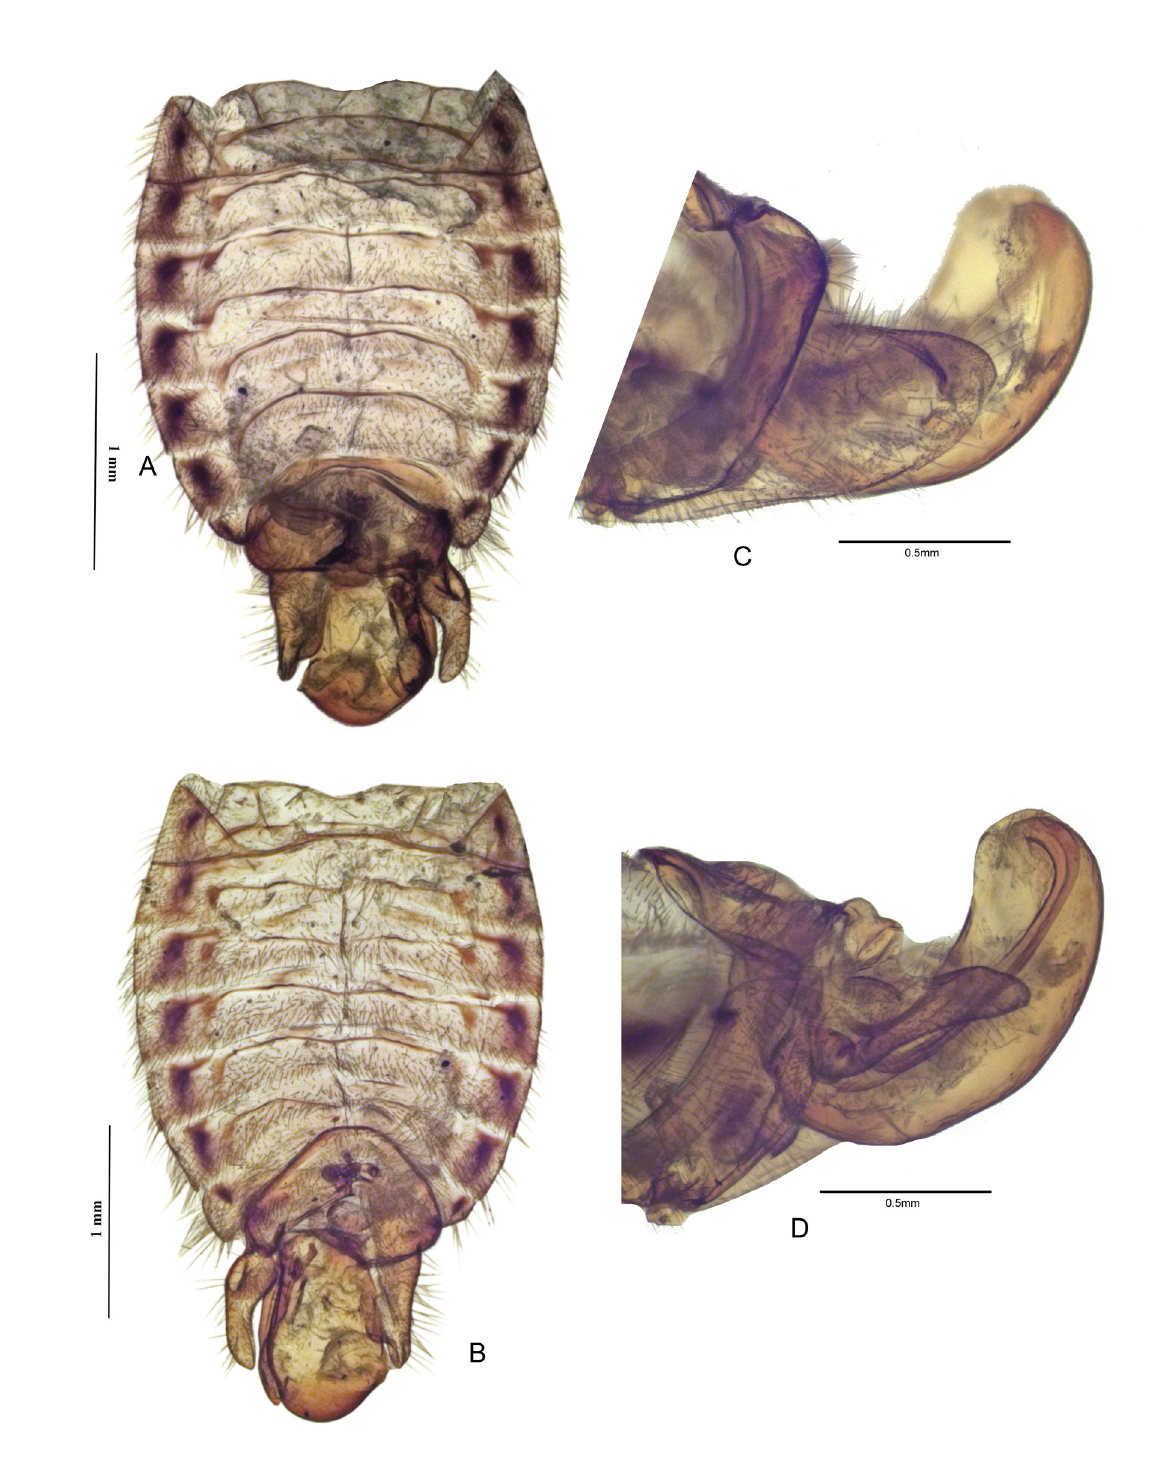
Fig. 17. Abdomen of Lopidolon dandeliensis sp. nov., ♂, holotype, UASB. A–B . Abdomen in dorsal and ventral views. C . Apex of abdomen in left lateral view. D . Apex of abdomen in right lateral